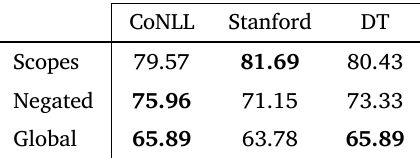
Performance of the NR system with gold cues on the Conan Doyle development set for three dependency formats using the B&N parser